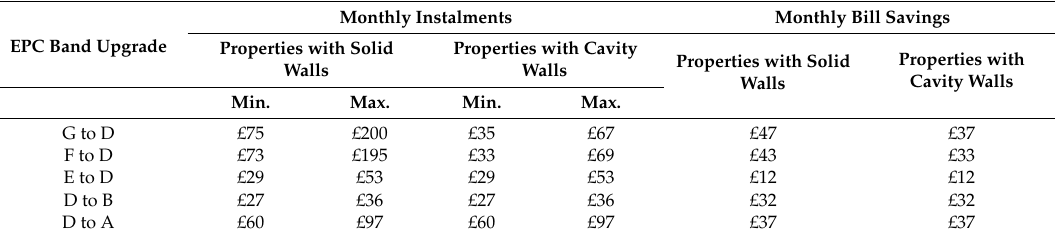
Table 7. Monthly instalments and energy bill savings for upgrading between different